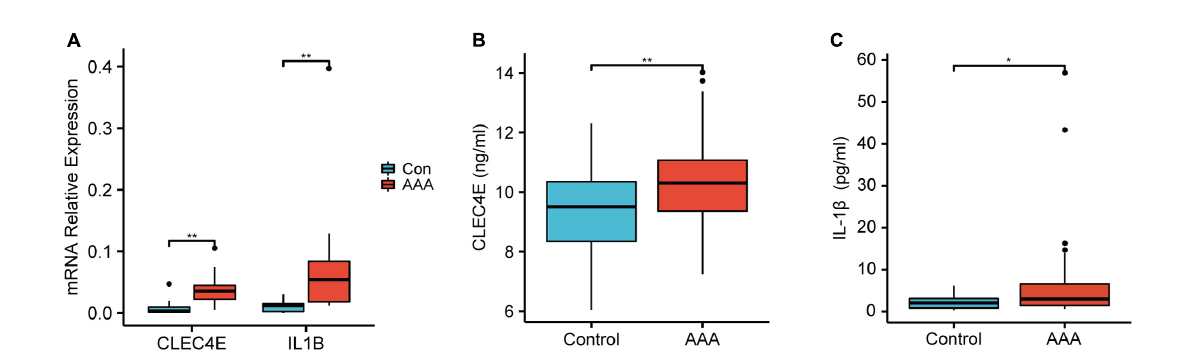
FIGURE6 Validation of the gene expression and serum protein level. Boxplot showing the relative expression of CLEC4E and IL1B in AAA ( N = 10) and control aortas ( N = 10) (A) . Boxplot showing the protein level of CLEC4E (B) and IL-1 β (C) in AAA ( N = 30) and control serum ( N = 10). * P < 0.05, ** P < 0.01.